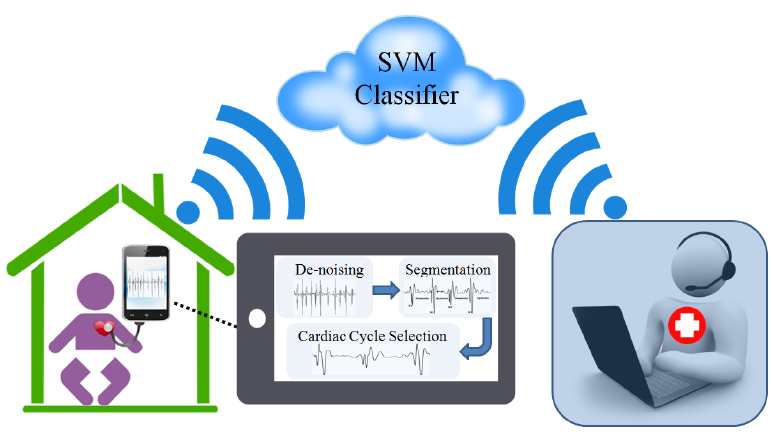
Figure 2. Schematic of telemedication frame work used in this